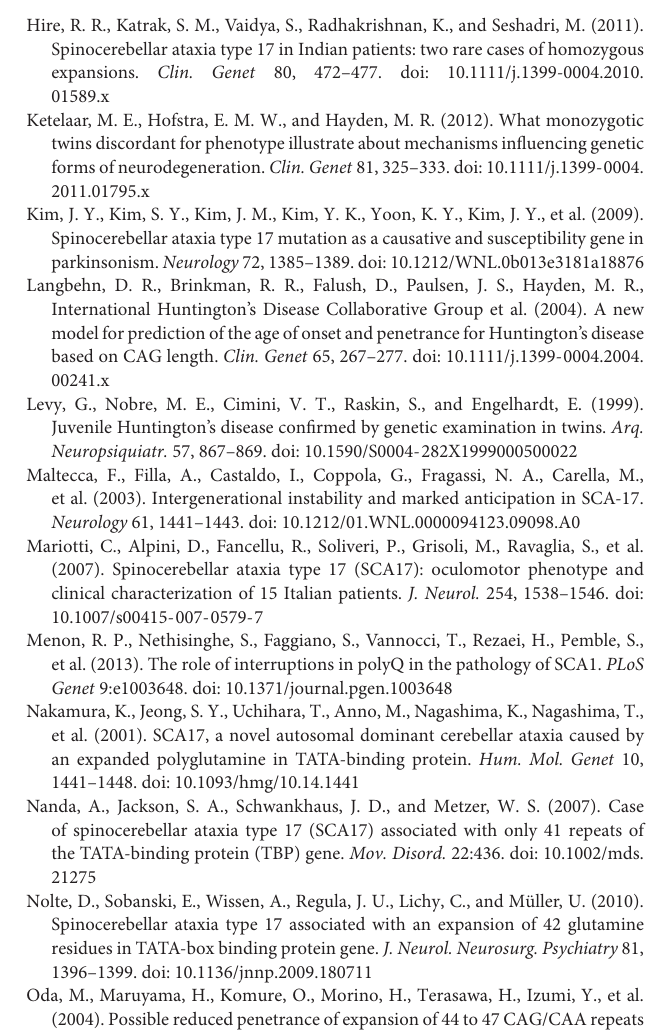
TABLE S3 | Fragment and sequence analysis of SCA17 alleles in four patients in an Italian cohort. SCA17 alleles were sized by fragment analysis and subsequently sequenced at the Institute of Translational Pharmacology, Rome. Interestingly, two of these patients, G31 and G32, lack the final (CAA/CAG) Domain V interruption which is observed in all clones from the United Kingdom cohort bar one. These patients also had a later age at disease onset for their expanded allele size, compared to patients with similar sized alleles (#4, 51 repeats, 21 years; #9, 52 repeats, 45 years). TABLE S4 | Summary of age at disease onset and allele size data for each individual. Data is presented from both fragment sizing and clone sequencing normal and expanded alleles. Age at onset data was available for 21 out of 30 individuals. Patient #8 (highlighted in blue italics) had a genetic diagnosis of ARCA1/SCAR8 (see text), which explains the early age at onset despite the 41 repeat SCA17 allele. This data was used to compile the graphs in Figure 3 . TABLE S5 | Short tandem repeat (STR) analysis to confirm identity of individuals #4, 5, 13, and 16. The PowerPlex 16HS System was used to amplify microsatellite markers at 15 STR loci. Numbers represent the alleles (repeat numbers) at that locus. This data confirms that father (#5) and child (#4) are separate samples and yet have the same 51-repeat pathogenic alleles with marked difference in phenotype. The monozygotic twins (#13 and #16) share the same alleles across all loci